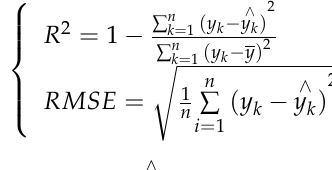
clouds clustered based on 2D-DBSCAN; ( c ) convex hulls; ( d ) plane projections of point clouds.